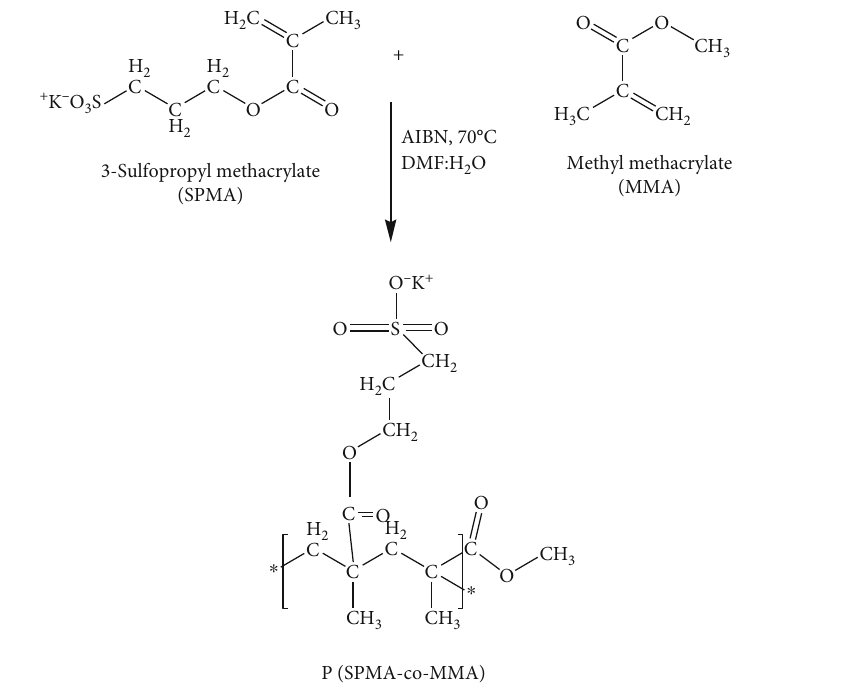
Figure 1: Synthesis of copolymers P(SPMA-co-MMA) through polymerization of 3-sulfopropyl methacrylate (SPMA) and methyl methacrylate